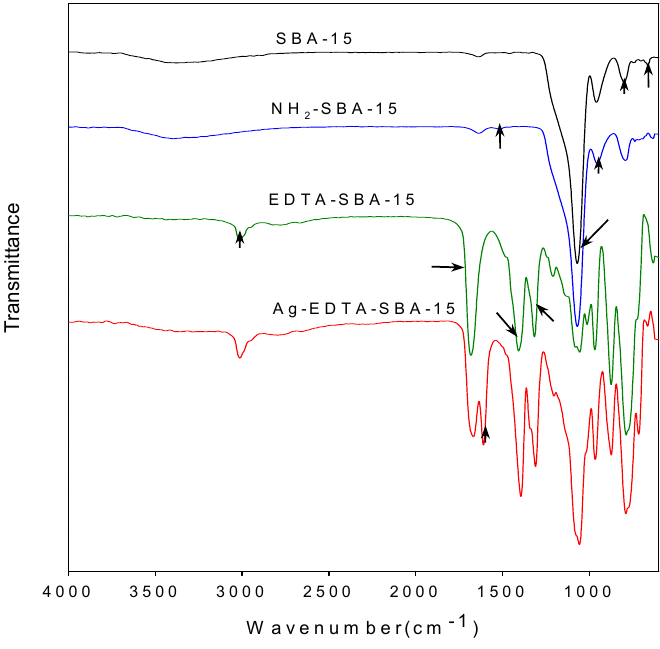
Figure 2. Comparison of FTIR spectra of SBA-15, NH 2 -SBA-15, EDTA-SBA-15, and Ag-EDTA-SBA-15.